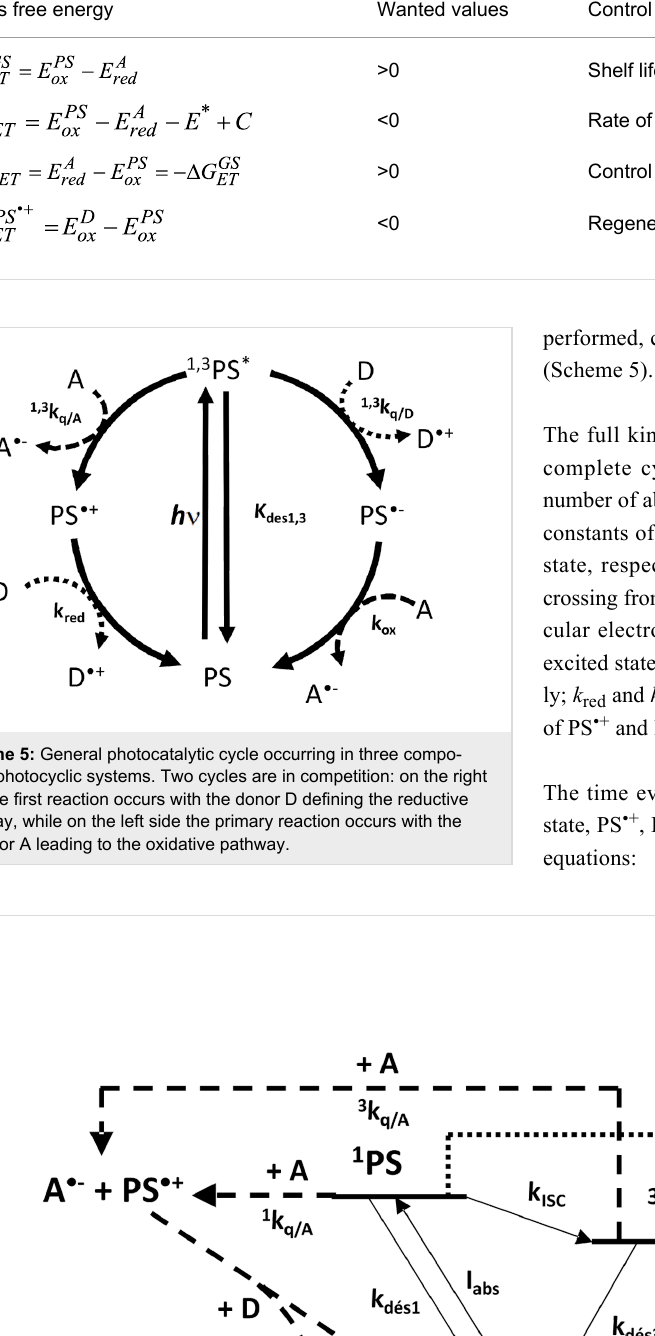
Table 1: Gibbs free energy of the different electron transfer reactions occurring in a three component PCIS. Gibbs free energy